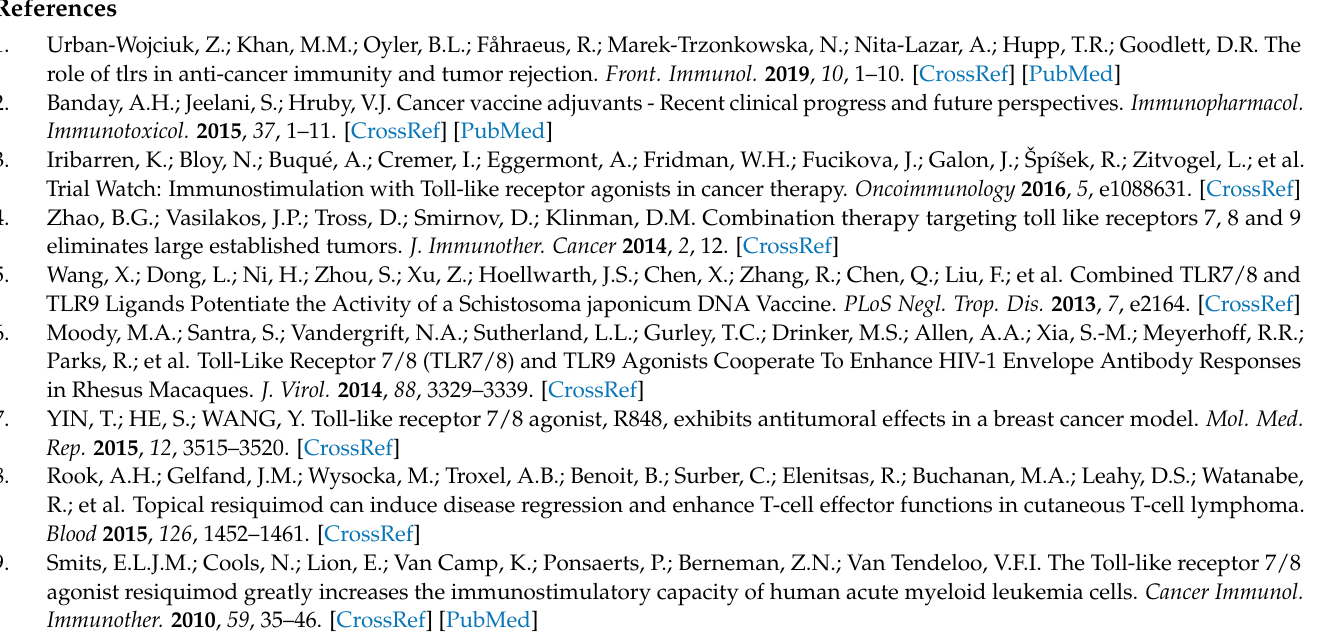
Figure S1: Bodyweight change among mice treated with saline, R848 NE, SD-101, R848 NE+SD-101 during the